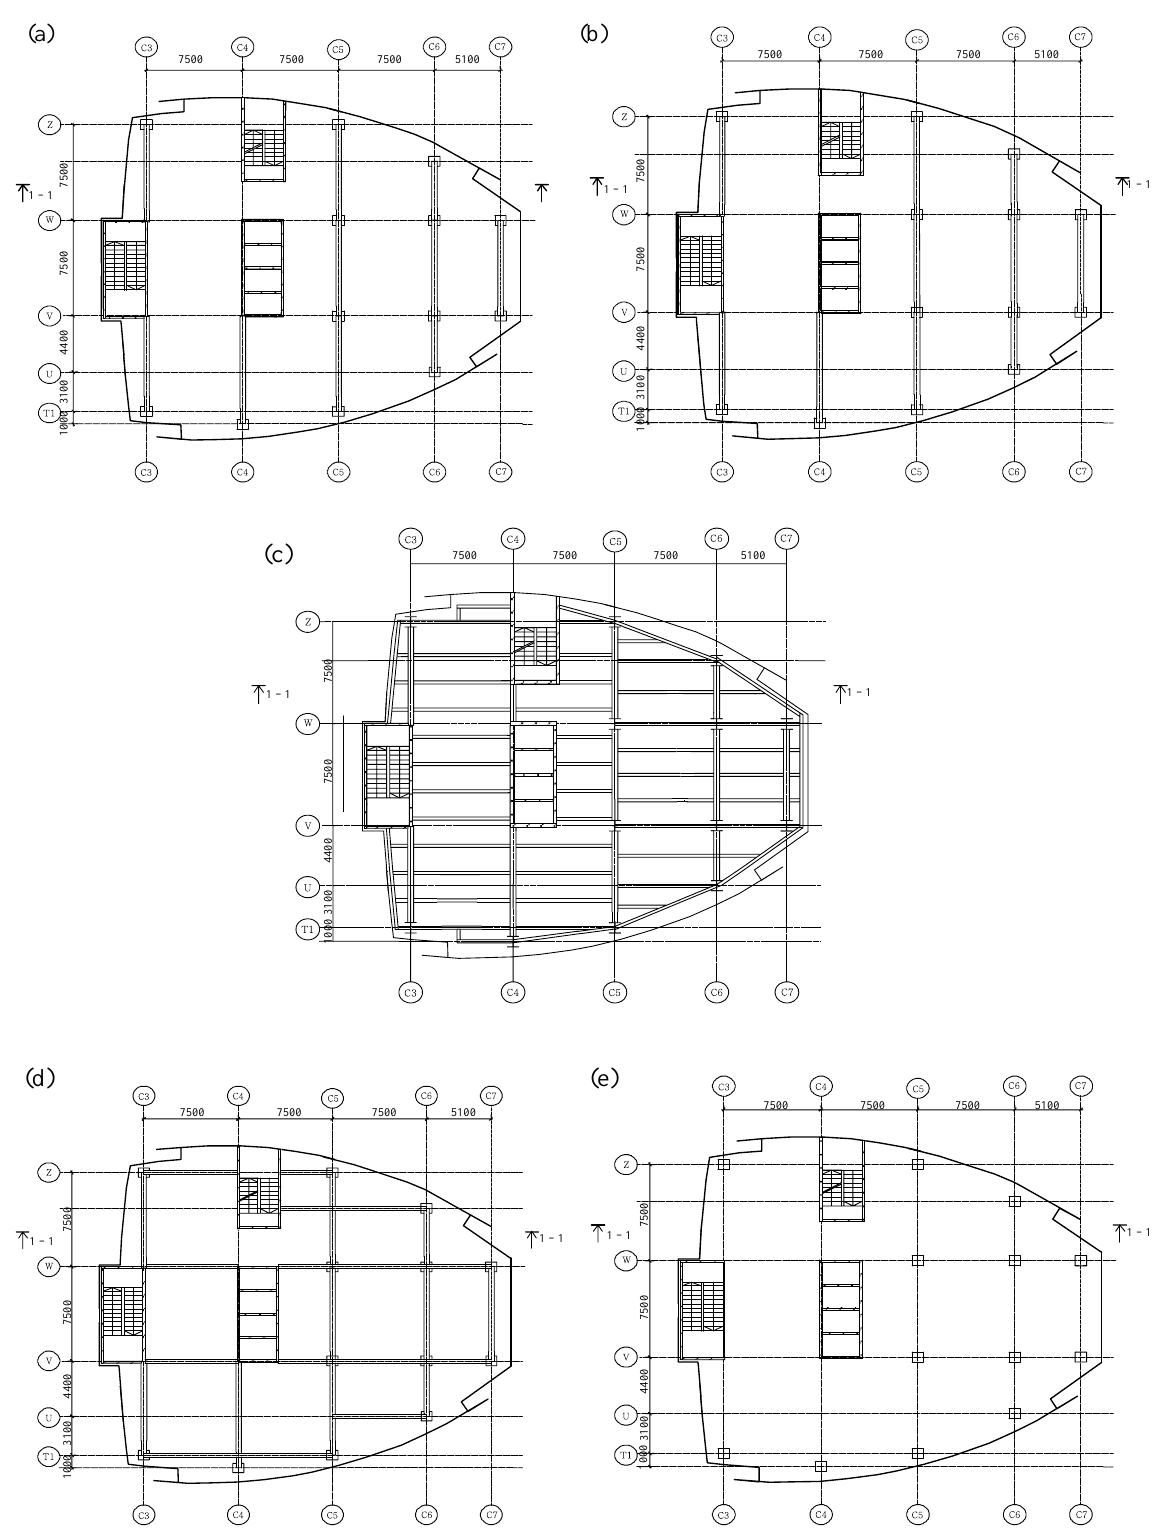
Fig. 3. Complex assessment model of a structural system used in a high-rise